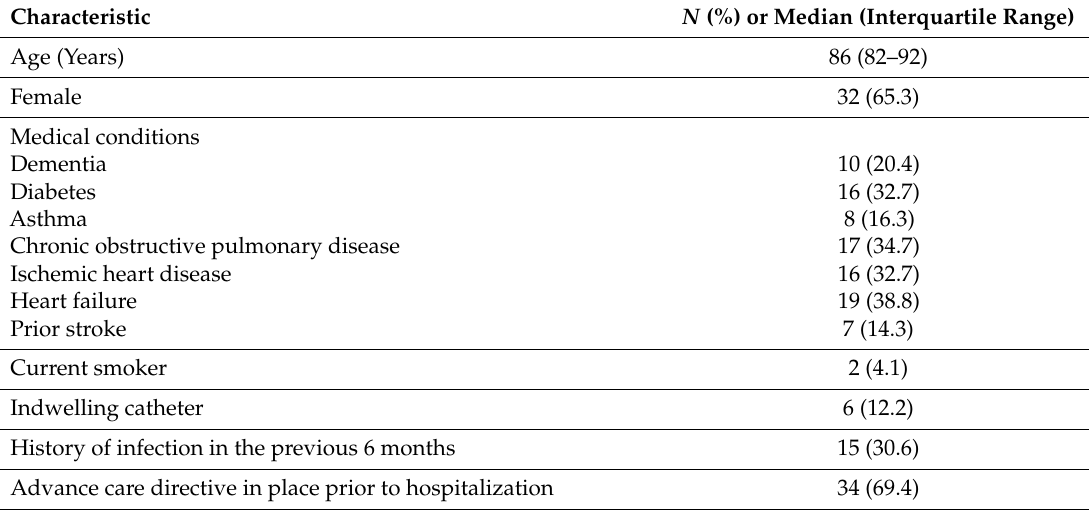
Table 2. Resident characteristics at the time of the infection-related hospitalization ( n = 49 hospitalizations).